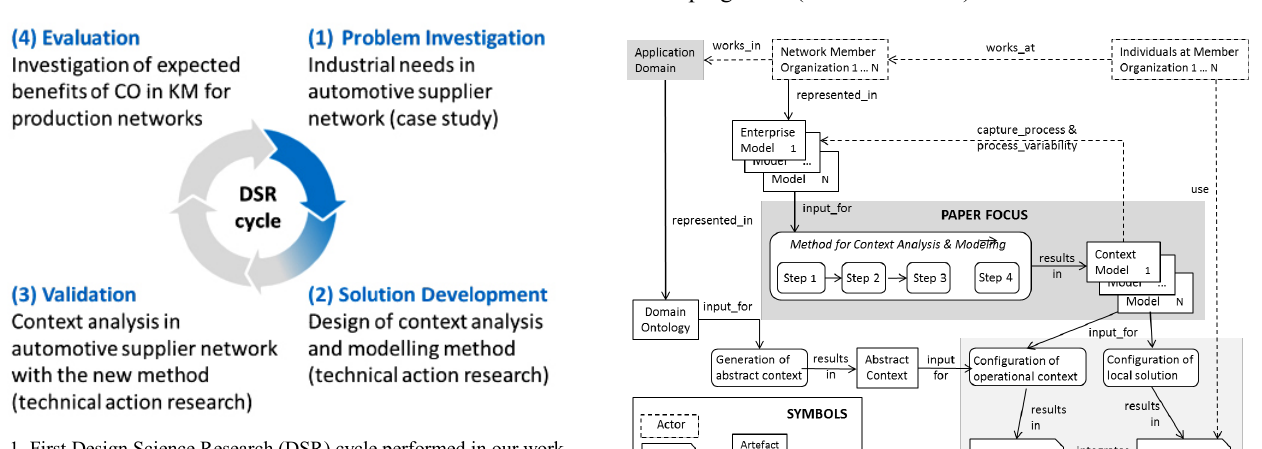
Fig. 1. First Design Science Research (DSR) cycle performed in our work.